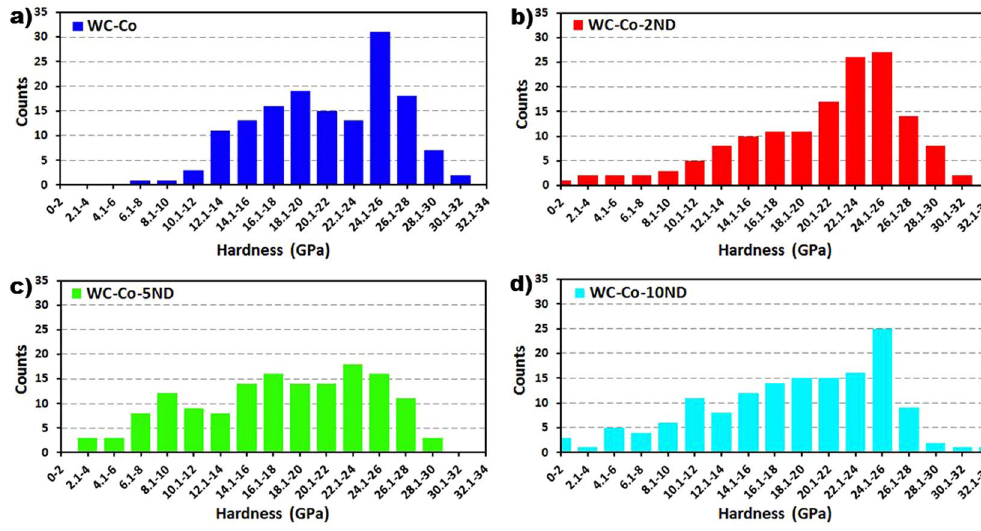
Figure 7. Distributions in nanohardness measured via nanoindentation; ( a ) WC-Co, ( b ) WC-Co-2ND, ( c ) WC-Co-5ND, ( d )